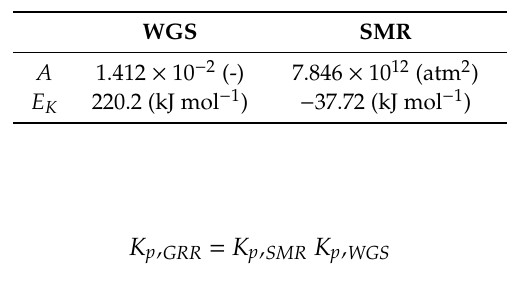
Table 4. Parameters for the calculation of K p through Equation (32) [64].